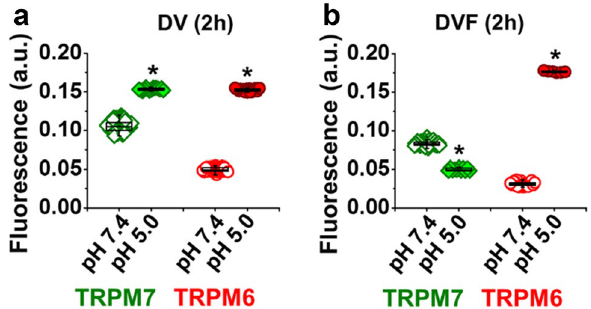
Figure 4. Effect on incubating human cardiomyocytes in acidic solution on the immunofluorescence of TRPM6 and TPRM7. ( a, b ) Quantification of the intensity of fluorescence at pH = 7.4 ( open symbols ) and at pH = 5.0 ( filled symbols ) expressed in arbitrary units (a.u.) with and without divalent cations, respectively. * P < 0.001 pH 5.0 vs. pH 7.4. Other notations are the same as in Fig. 1. Extracellular acidification differently changes the fluorescence level of the immunodetected TRPM7 ( filled diamonds ) and TRPM6 ( filled circles ) proteins in human cardiomyocytes depending on the presence of divalent cations in the milieu.